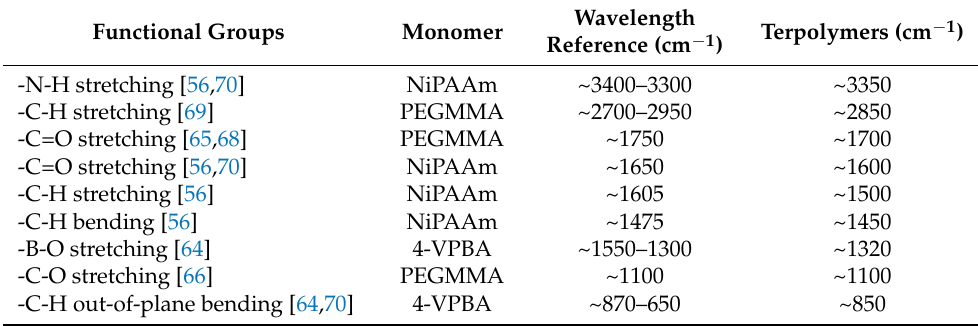
Table 1. Summary of characteristic functional groups of monomers identified in the FT-IR spectra